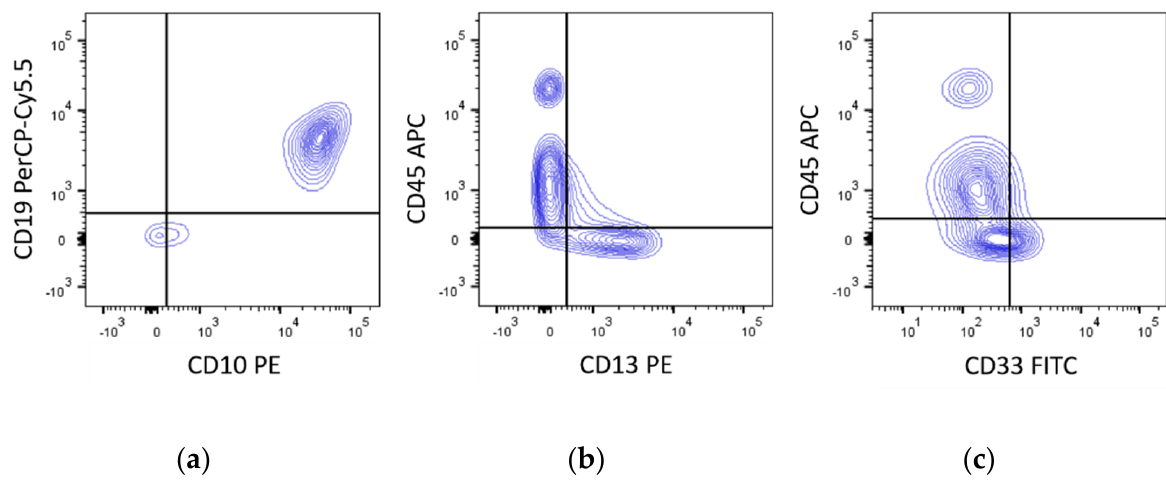
Figure 9. FACS analysis of CML-BP-lymphoid (CD10, CD19) with co-expression of myeloid (CD13, CD33) markers.